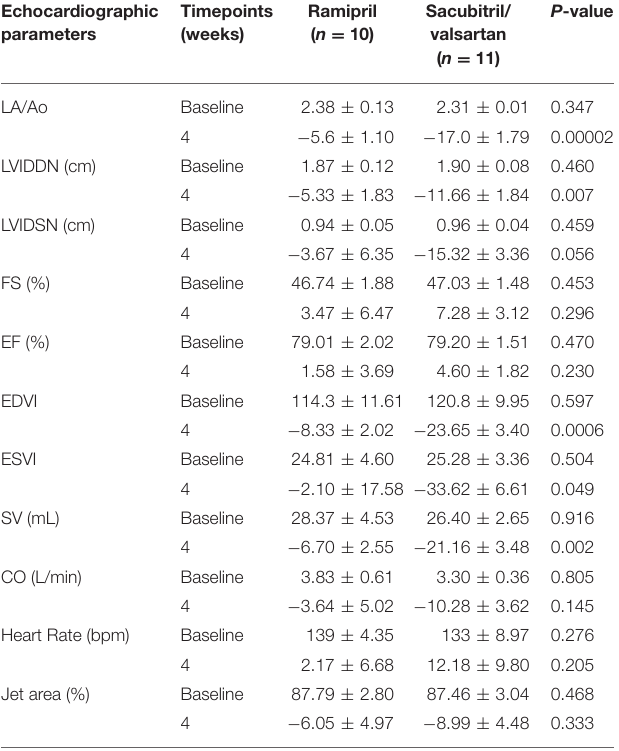
TABLE 2 | Effects of ramipril and sacubitril/valsartan on echocardiographic parameters in dogs with naturally occurring, symptomatic myxomatous mitral valve degeneration.